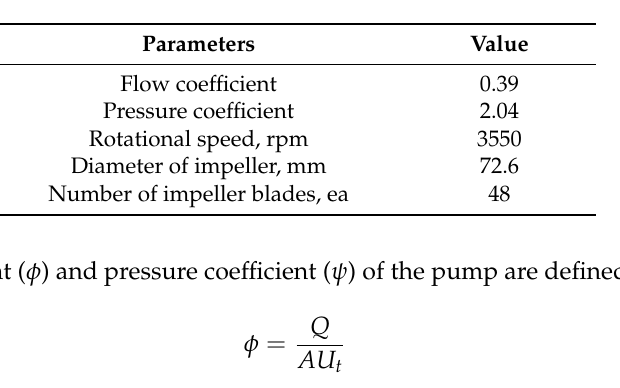
Table 1. Specifications of test microbubble